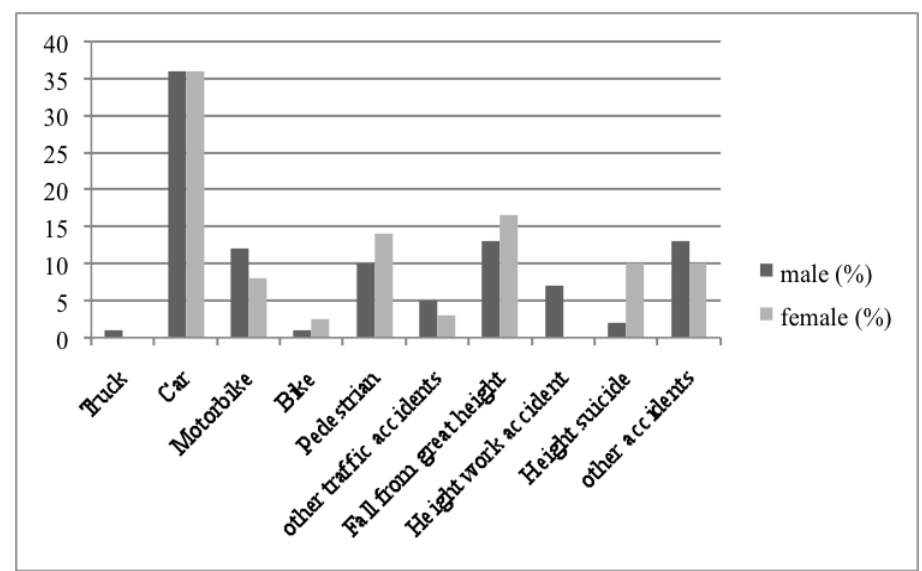
Figure 1. Trauma events.